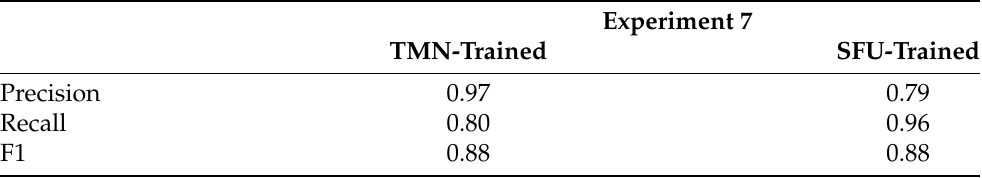
Table 9. Results for negation cue detection testing on the SFU Review SP -NEG